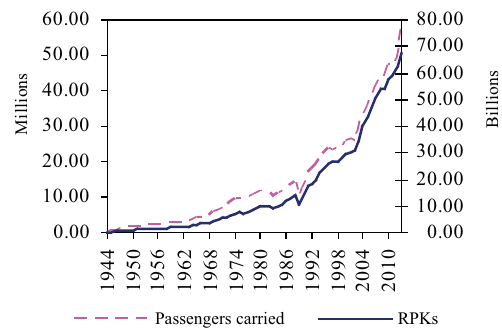
Fig. 1. Development of Australia’s annual enplaned domestic passengers and revenue passenger kilometres performed (RPKs): 1944–2013 (Bureau…